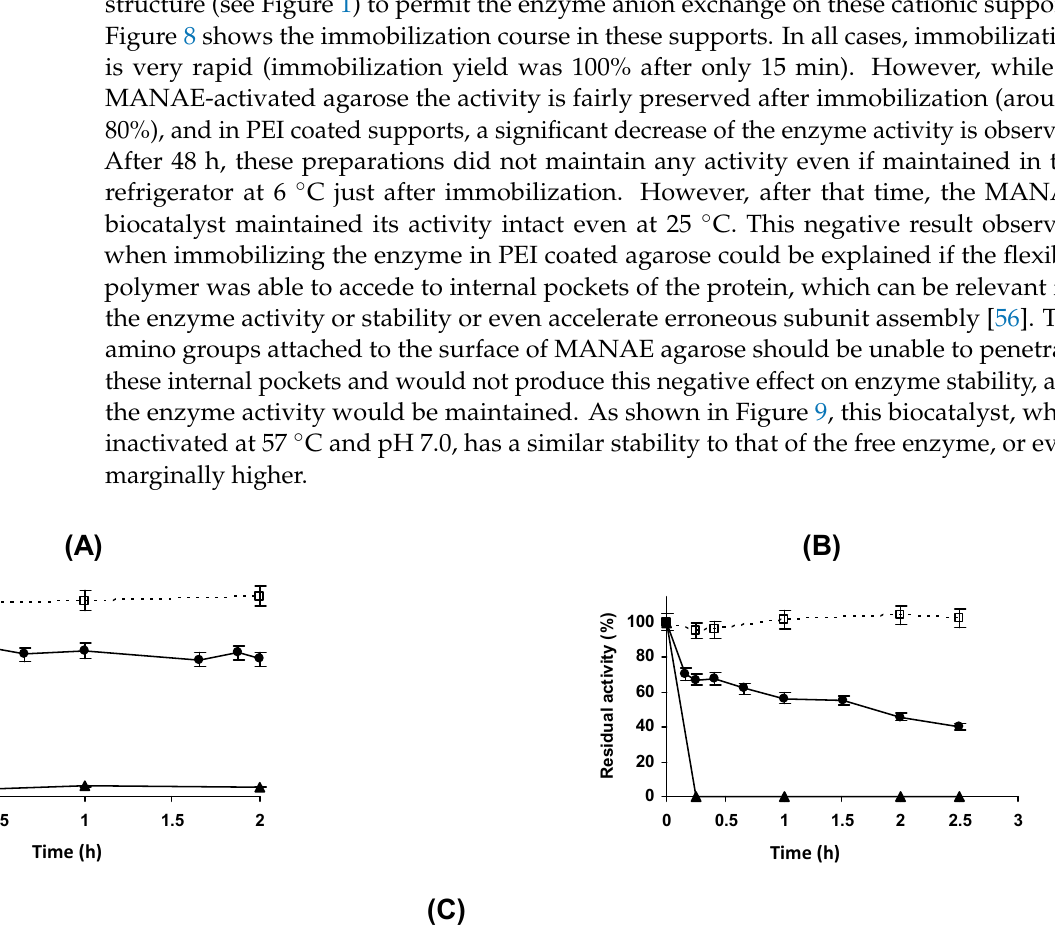
Figure 9. Thermal inactivation of r Aae UPO immobilized on MANAE agarose support. Inactivation was performed in 10 mM Tris at pH 7.0 and 57 °C. Other specifications can be found in the Meth- ods section. Full circles: MANAE agarose biocatalyst; empty squares with dotted line: free en- zyme. Considering the good properties of this biocatalyst compared to the covalent prepa- rations, we tried to improve its performance using two different strategies. First, the immobilization on MANAE agarose was also performed at pH 5.0 and 9.0 (Figure 10) and compared to that at pH 7.0, as it has been shown that the immobilization pH may greatly alter the final properties of the enzymes immobilized via anion exchange [48,61,102]. Compared to the immobilization of the enzyme at pH 7.0, the main difference is a higher expressed activity when immobilizing the enzyme at pH 5.0 (over 95%), while at pH 9.0 the expressed activity is around 80%, similar to the results obtained at pH 7 (Figure 8). However, immobilization yield was 90% for the immobilization performed at pH 5.0 and almost 100% if the immobilization was performed at pH 9. At pH 5.0, the cationic nature of the support is reinforced, while the anionic nature of the enzyme is de- creased (the theoretic isoelectric point of the enzyme from the enzyme primary sequence